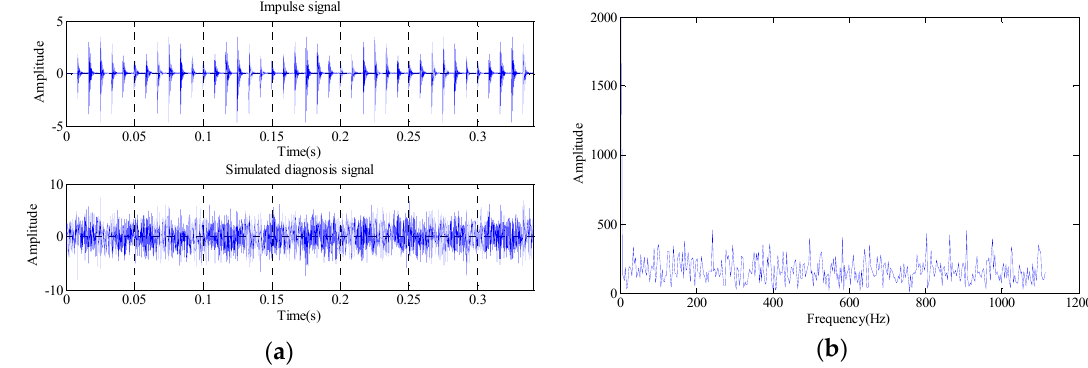
Figure 9. Time domain and envelope spectrum waveform of simulated signal. ( a ) Time domain waveform; ( b ) Envelope spectrum waveform.